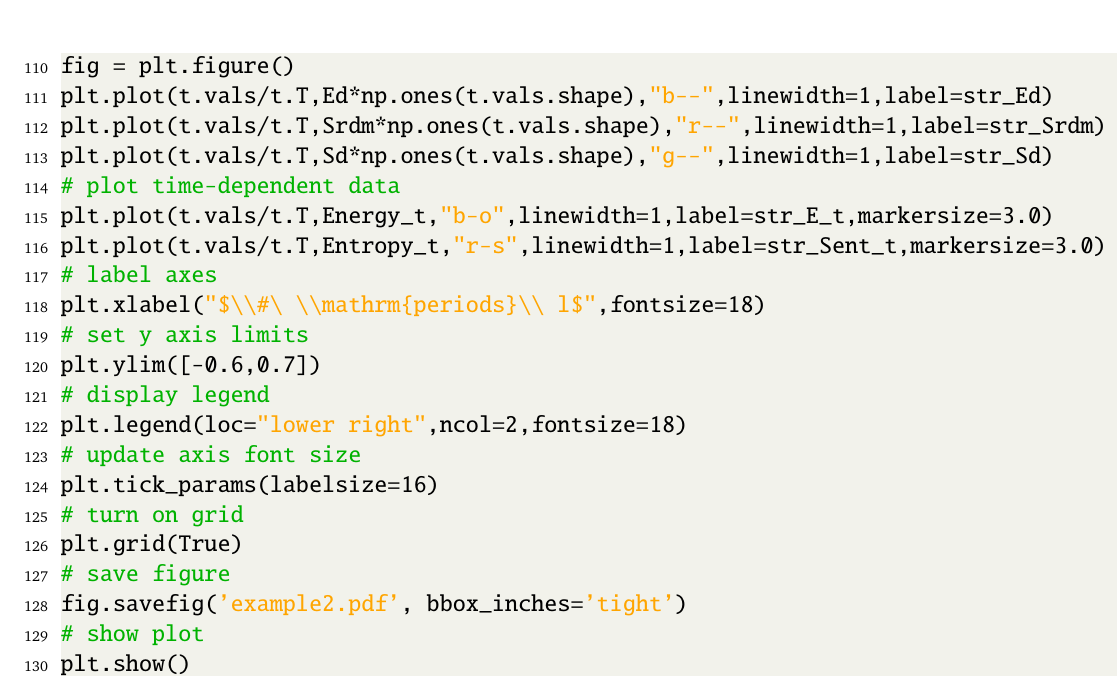
128 fig.savefig(’example2.pdf’, bbox_inches=’tight’) 129 # show plot 130